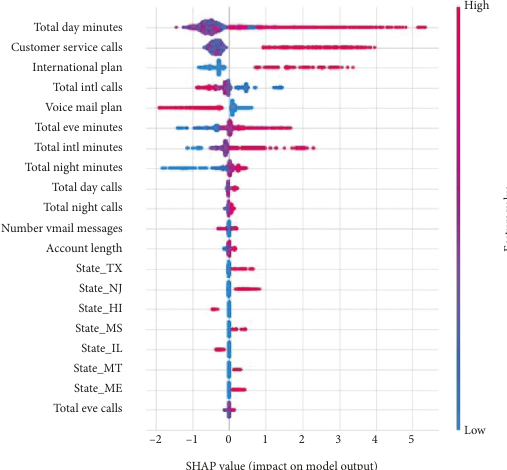
Figure 11: SHAP summary of orange